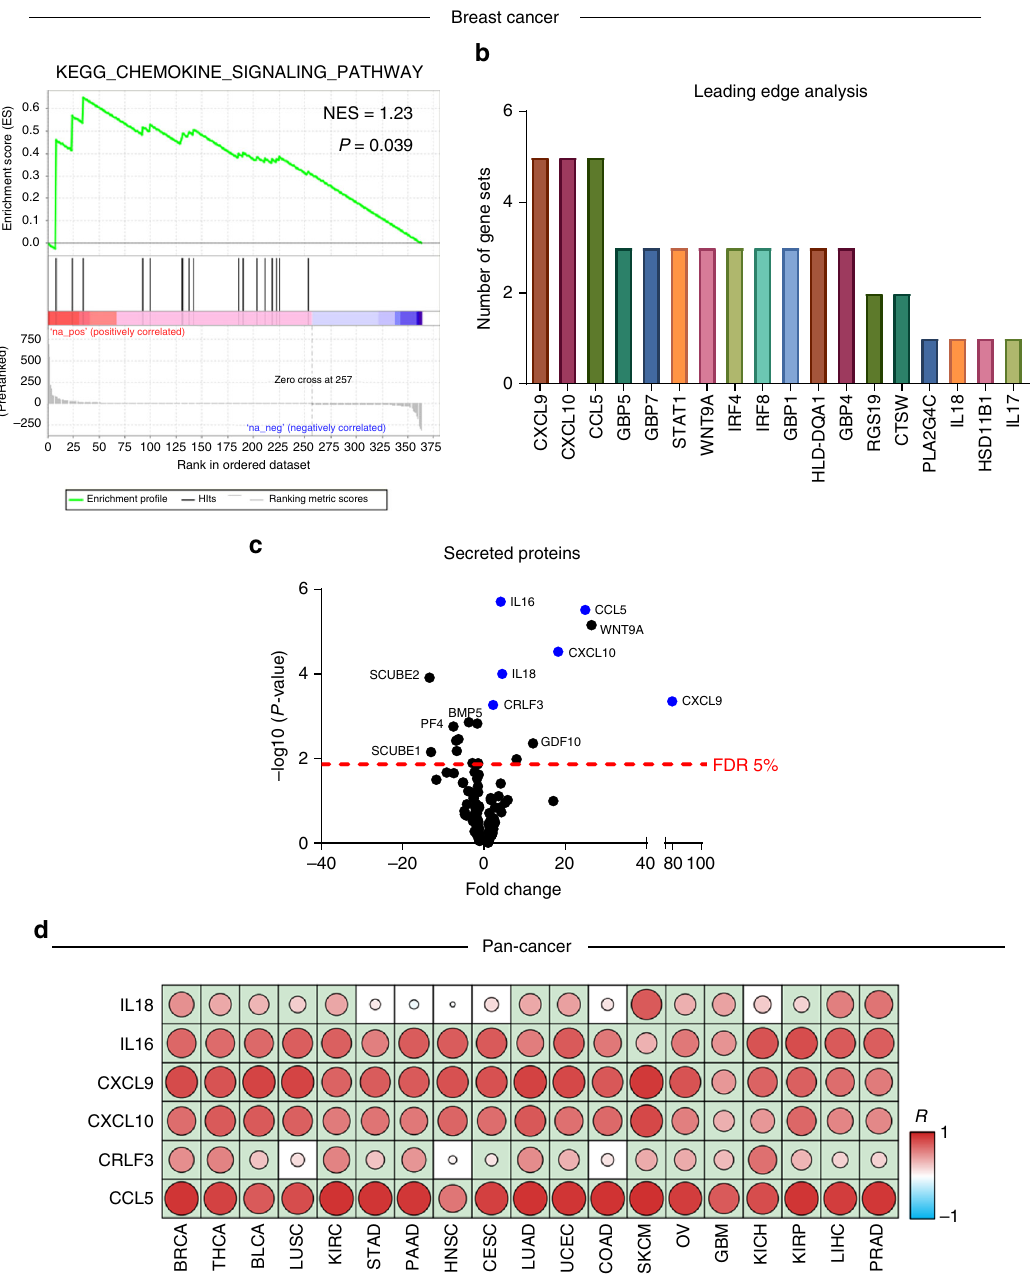
Fig. 3 Identi fi cation of cytokines responsible for CTL invasion across multiple cancers. a Gene set enrichment analysis for total proteins in CTL high breast cancer. b Leading edge analysis of top ten enriched gene sets shows soluble factors are driving most of the enriched gene sets. c Volcano plot showing differential expression of secreted proteins in CTL high vs. CTL low patients. Dotted line indicates false discovery rate (FDR) of 5%. Proteins which show positive correlation between protein and gene transcript levels are indicated in blue. See Supplementary Fig. 4. d Pan-cancer analysis of correlation between CTL score and cytokine expression levels. Correlation coef fi cient ( R ) indicated by color of the spot, with signi fi cant correlations indicated by light green background. Sample sizes and exact P -values given in Supplementary Table